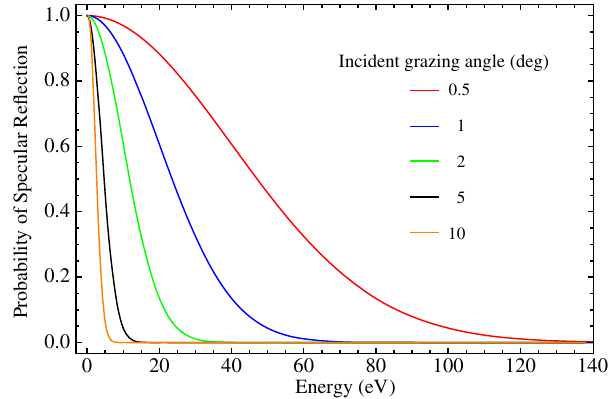
FIG. 6. Diffuse scattering out-of-plane angular distributions for 30 eV photons, σ ¼ 200 nm and T ¼ 5500 nm. The full diffuse scattering expression [Eq. (A97)] has been used to calculate these curves.